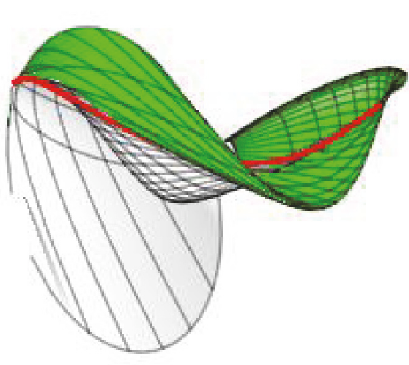
Figure 8: Projection of IS 𝛾 ± (𝑠,𝜇) (in green and in gray) and C 𝛾 (𝑠) (in red) on 𝑥 1 𝑥 2 𝑥 4 -space.